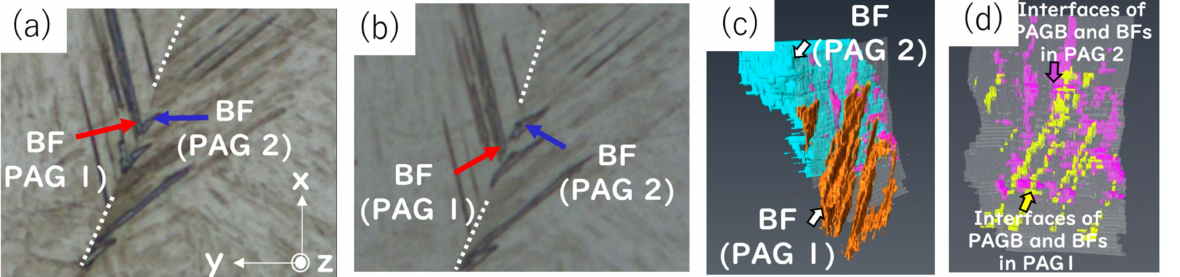
Figure 4. ( a ) The OM image of BFs, ( b ) the OM image of BFs at the same position in x- and y-directions but different positions in the z-direction. The identical BFs are indicated by the red and blue arrows, respectively. ( c ) the corresponding three-dimensional image, and ( d ) the contact regions of the BFs and the PAGB plane (yellow: contact regions of BFs in PAG 1 and PAGB, purple: contact regions of BFs in PAG 2 and PAGB).